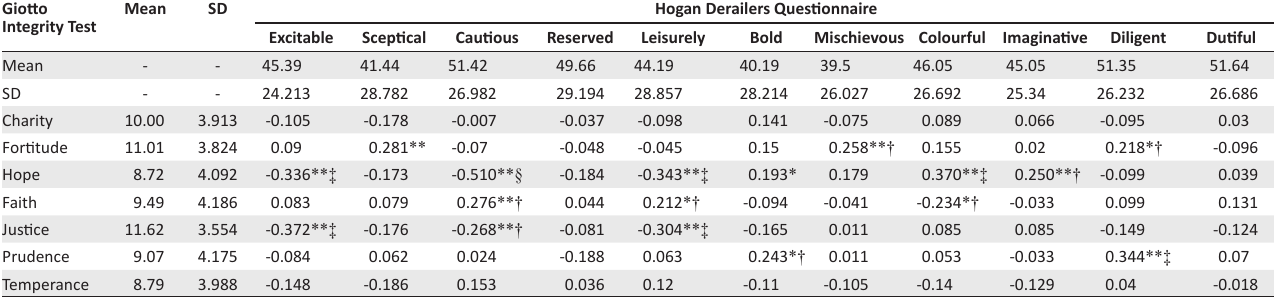
TABLE 3: Correlations between the scales of the Giotto Integrity Test and the Hogan Derailers Questionnaire. Giotto Integrity Test